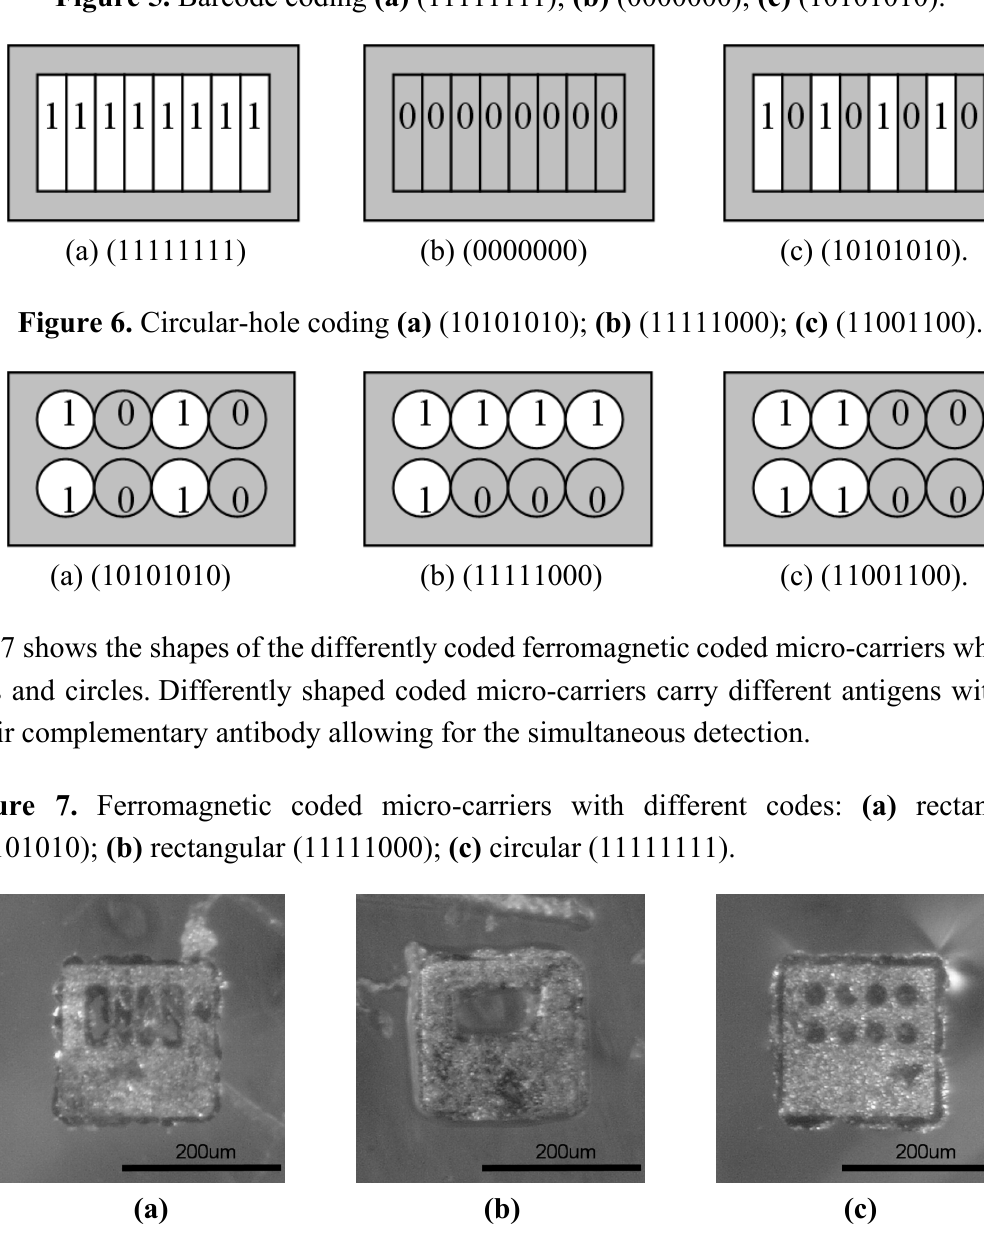
Figure 5. Barcode coding (a) (11111111); (b) (0000000); (c) (10101010).